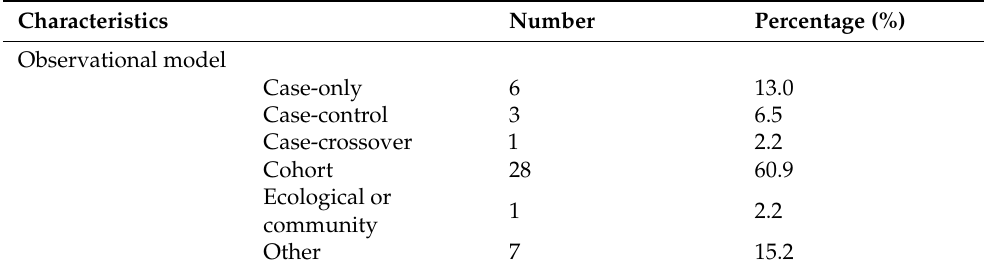
Table 3. Study design elements of observational